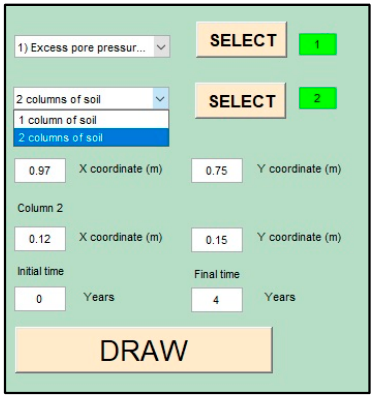
Figure 10. Selection of soil columns to be represented and time interval.